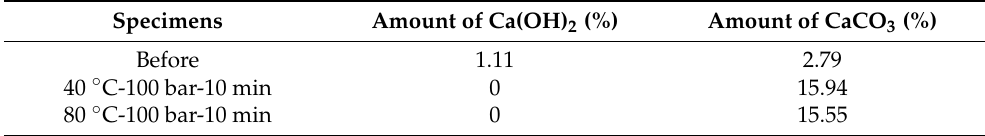
Table 3. The amount of Ca(OH) 2 and CaCO 3 before and after supercritical CO 2